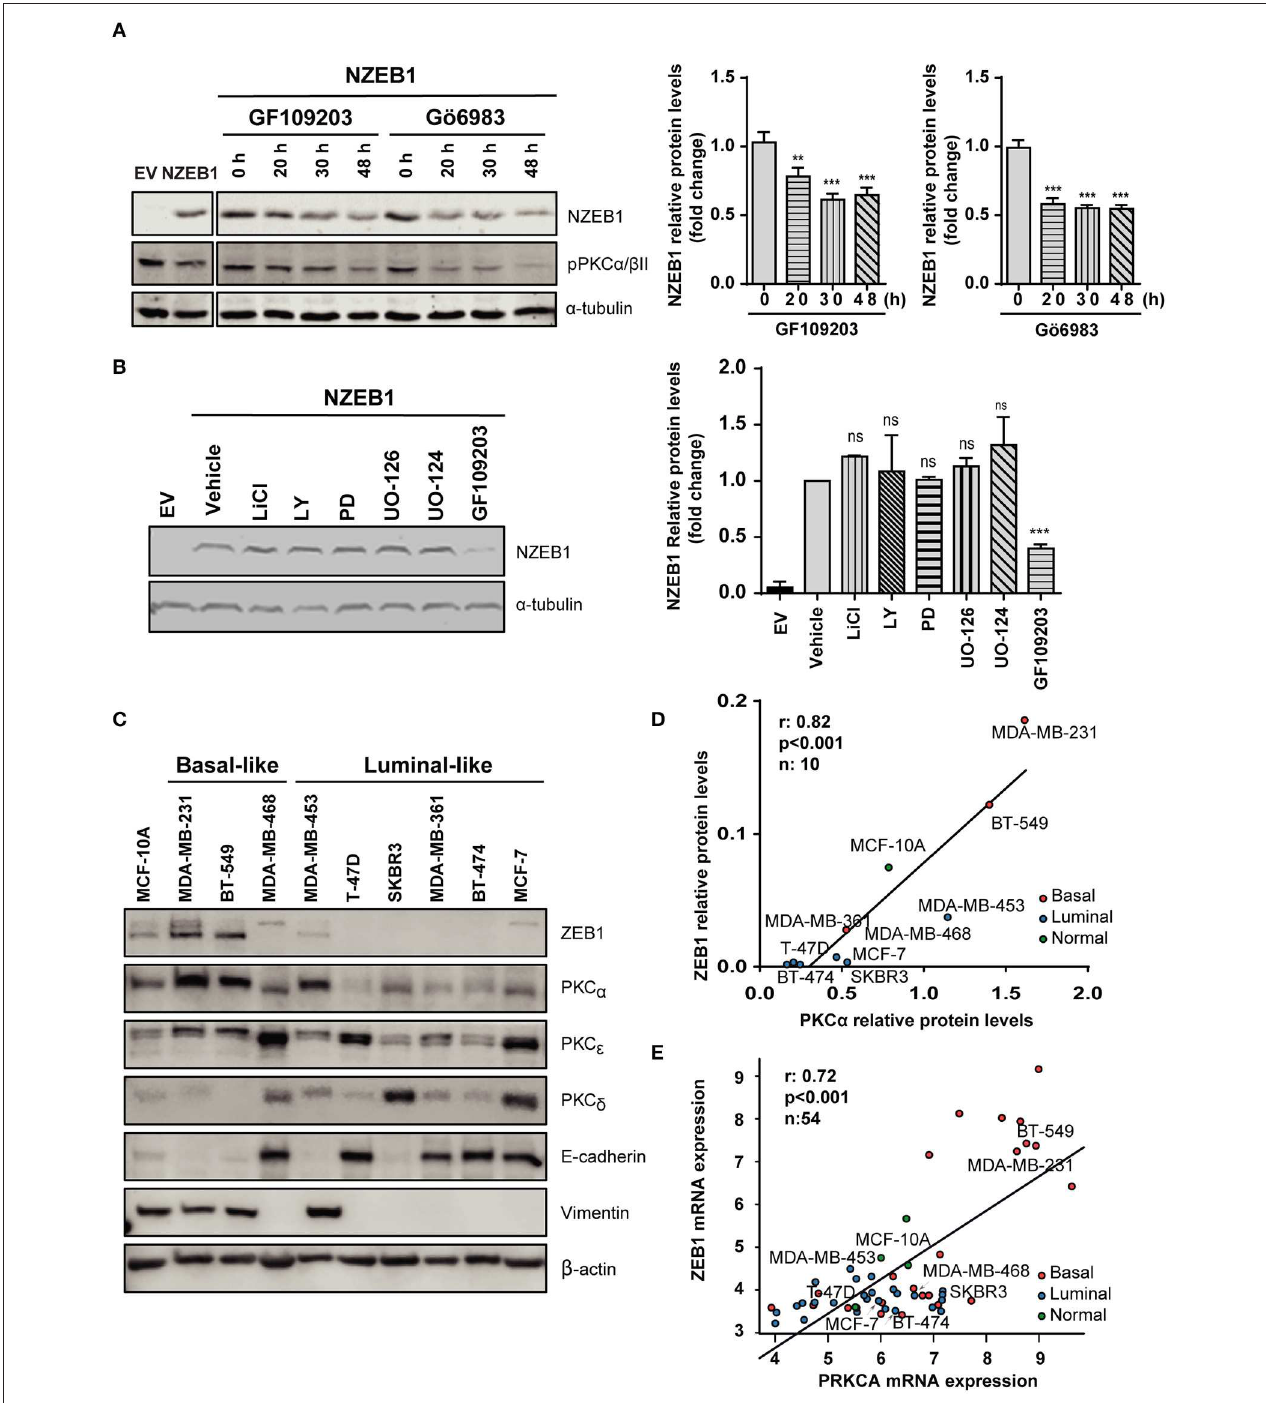
FIGURE 2 | PKC α levels and activity correlate with ZEB1 levels in breast cancer cells. Western blot analysis of NZEB1 levels in NMuMG-NZEB1 cells (A) treated with the pan-PKC inhibitors GF109203X ( GF ) or GÖ6983 ( GÖ ) (5 µ M) for the indicated times; or (B) treated with specific inhibitors of several signal transduction pathways: GSK3 inhibitor LiCl (50mM), AKT inhibitor LY294002 ( LY , 20 µ M), MEK1/2 inhibitors PD98059 ( PD , 20 µ M) and UO126 and its respective negative control UO124 (20 µ M), pan-PKCs inhibitor GF109203X ( GF , 5 µ M) or DMSO (vehicle) for 48h. Graphs represent protein levels of NZEB1 (fold-change), normalized to the loading control and relativized to time 0h in (A) , or to DMSO (vehicle) in (B) . Results are expressed as mean ± S.D. ** p ≤ 0.01; *** p ≤ 0.001). (C) Western blot analysis of ZEB1, PKC α , PKC ε , PKC δ , and EMT markers (E-cadherin and vimentin) in breast cancer cells. (D) Analysis of protein expression levels of PKC α and ZEB1 in the entire set of breast cancer cell lines. Pearson r = 0.82. *** p ≤ 0.001. (E) In silico analysis of PKC α and ZEB1 mRNA expression among 54 breast cancer cell lines in the Heiser 2012 dataset. Pearson r = 0.72. *** p ≤ 0.001).